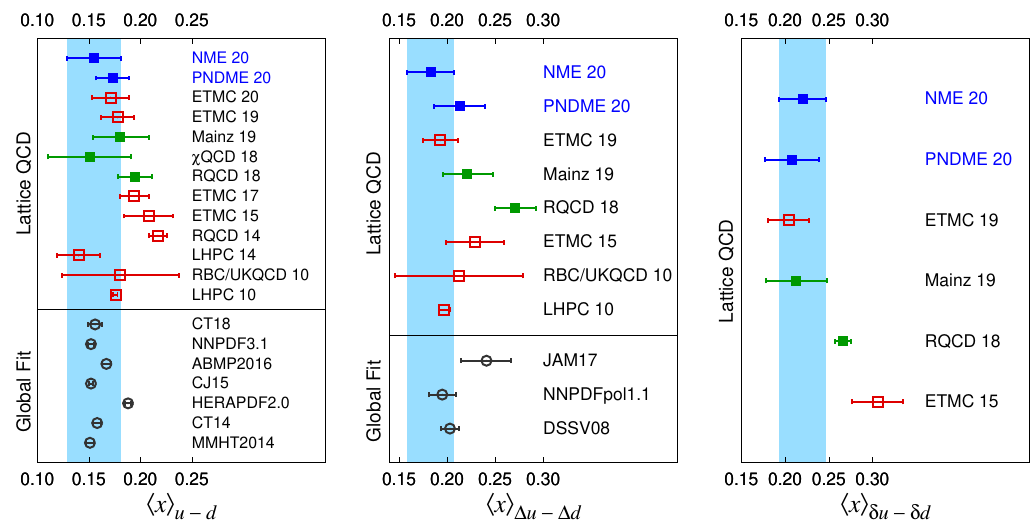
Figure 4 . A comparison of results from lattice QCD calculations with dynamical fermions and global fits (below the black line) summarized in table 5. The left panel compares results for the momentum fraction, the middle for the helicity moment, and the right for the transversity moment. Our NME 20 result is also shown as the blue band to facilitate